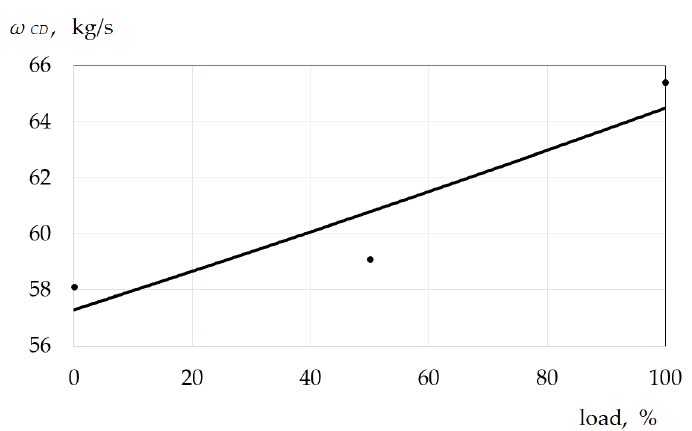
Figure 15. Dependence of mixing air flow rate for all combustion chambers on the load value.